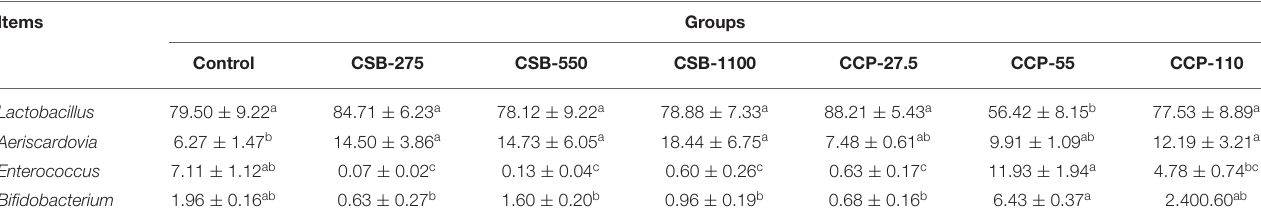
TABLE 5 | Abundance of main microbiota (accounting for ≥ 0.05% of the total sequences in at least one of the samples) in each group (abundance of the genera is expressed as a percentage). Items